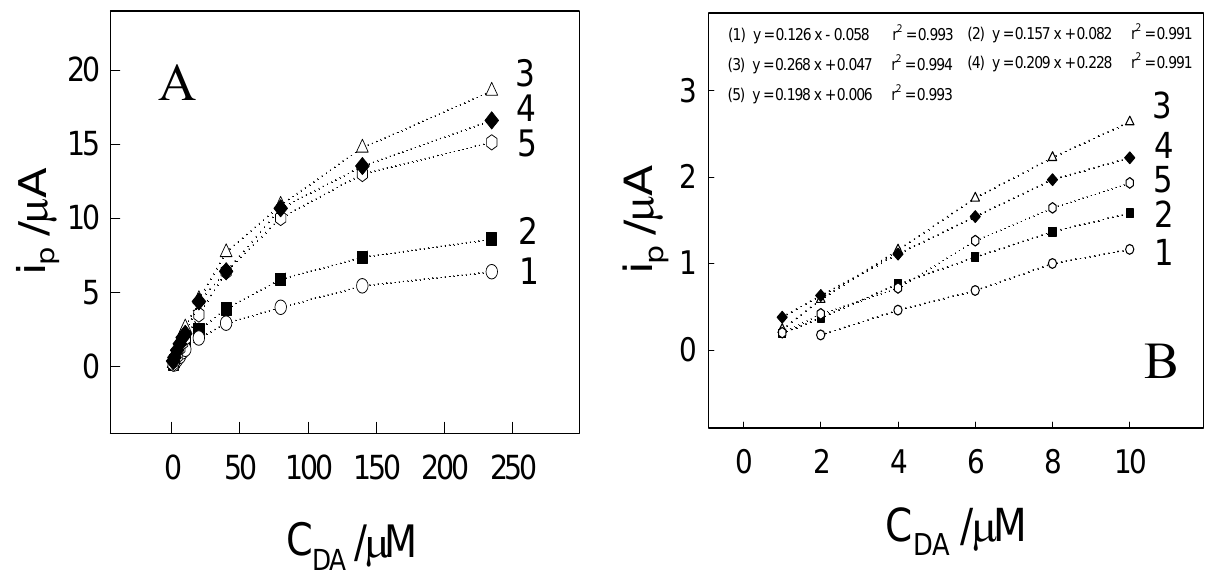
Figure 7 . DPV peak current of dopamine oxidation at 500 Hz PPY/TA film-modified electrodes versus DA concentration in PBS buffer (pH 7.4) containing different amount of ascorbic acid. AA concentrations for curves 1-5 are 0, 0.2, 1.0, 3.0 and 5.0 mM, respectively. (A) whole DA concentrations, (B) low DA